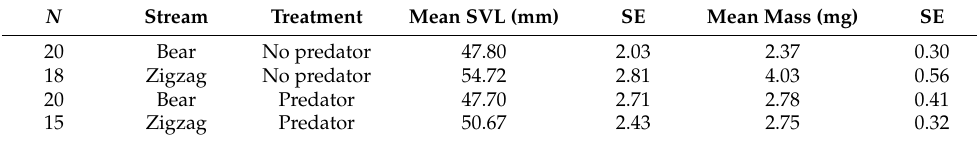
Table 1. Sample size, mean, and standard error of snout–vent length (mm) and mass (mg) for each population. Treatment refers to reaches in each stream with and without fish